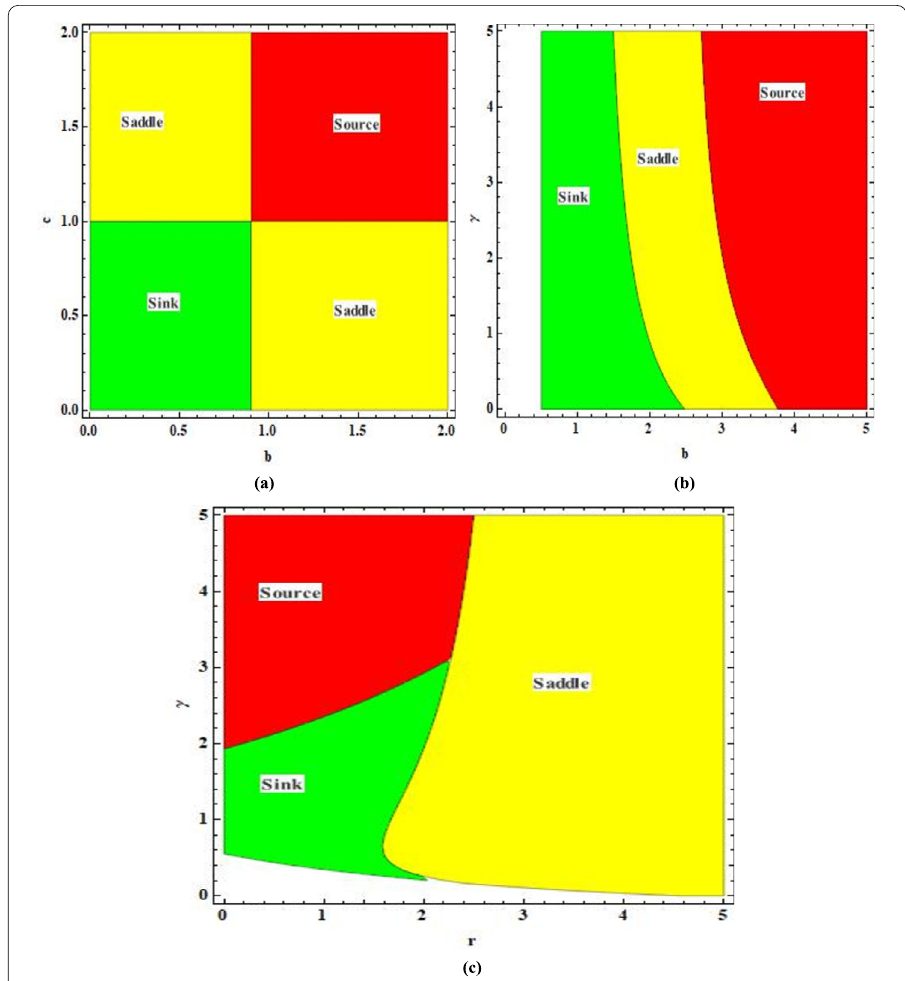
Figure 1 ( a ) Topological classification for trivial equilibrium for r = 0.1. ( b ) Topological classification of E 1 . ( c ) Topological classification for E